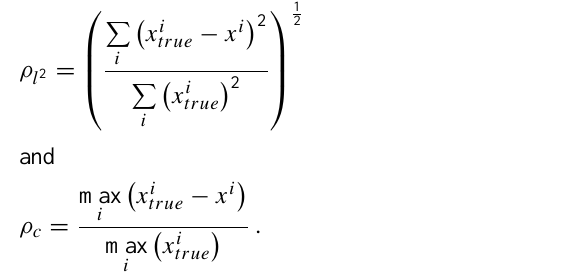
tron density in units of 10 7 cm − 3 )